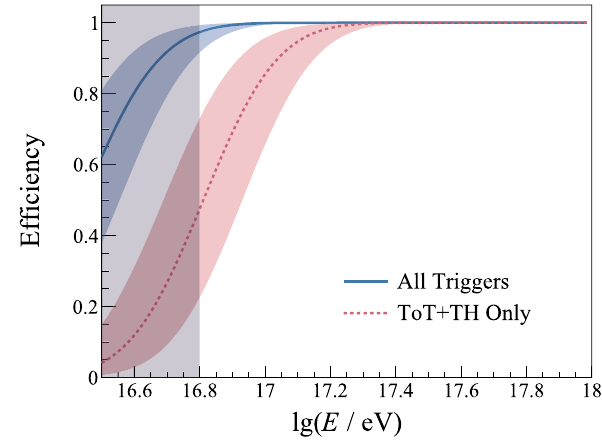
Fig. 5 The detection efficiency of the SD-750 for air showers with θ < 40 ◦ isshownfortheoriginal(dashedred)andexpanded(solidblue) station-level trigger sets with bands indicating the systematic uncertain- ties. The trigger efficiency was determined using data above 10 16 . 8 eV and is extrapolated below this energy (shown in